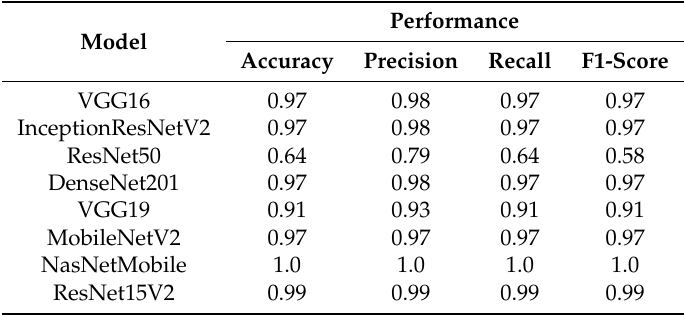
Table 5. Overall model’s performance on X-ray test set.